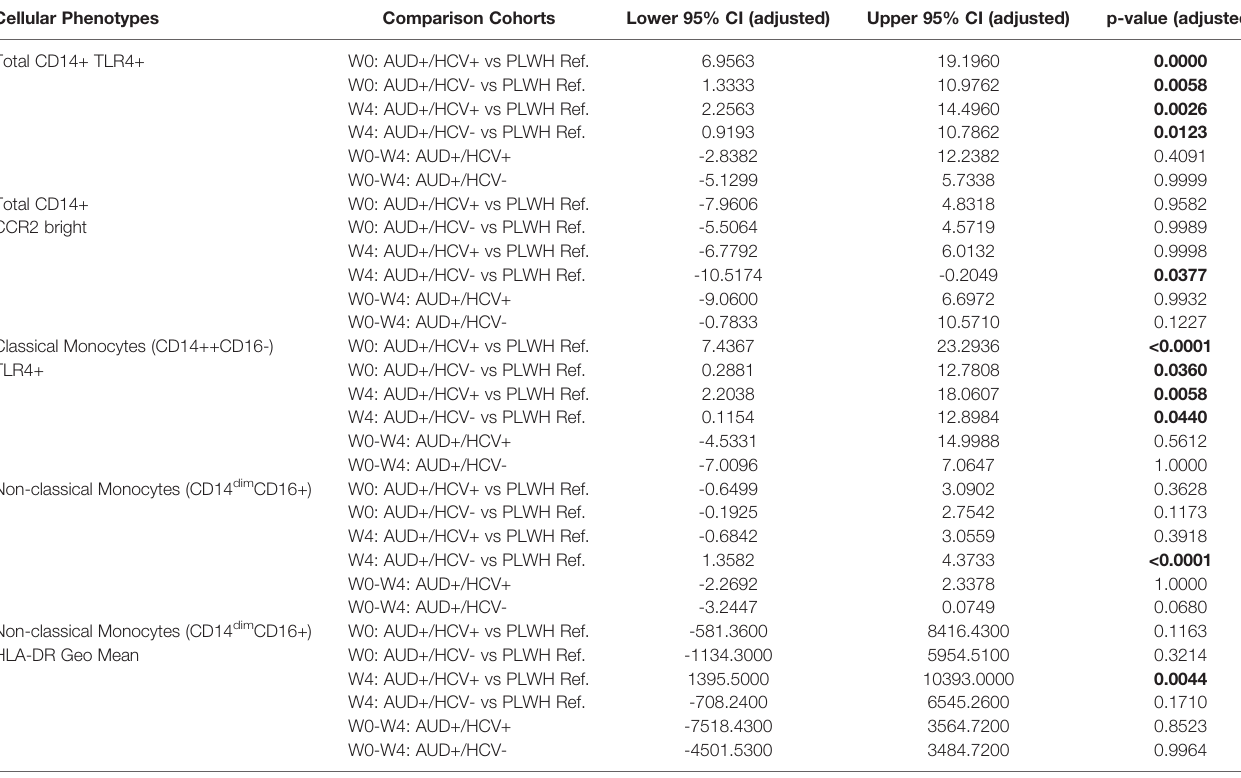
TABLE 4 | Signi fi cant differences in cellular phenotypes between PLWH with and without AUD by HCV co-infection. Cellular Phenotypes